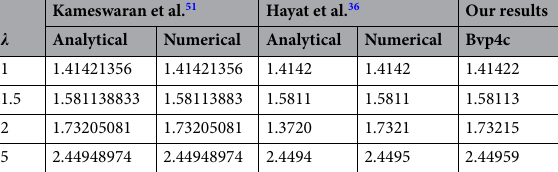
Table 2. Numerical results of f ′′ ( 0 ) obtained for increasing (cid:31) by taking γ 1